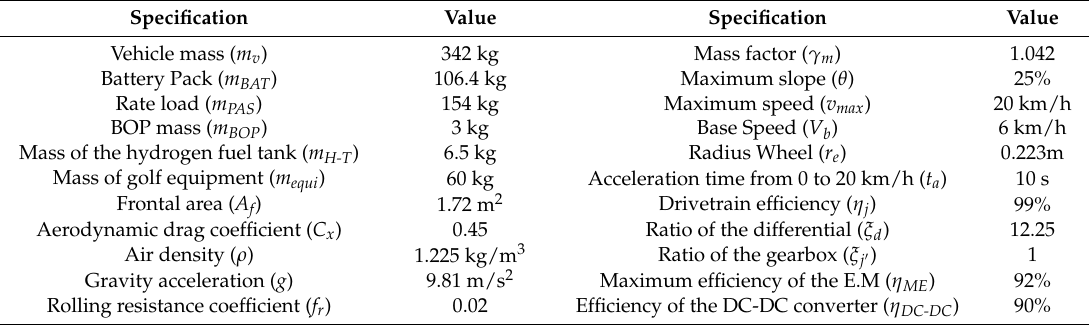
Table 3. Specifications of golf